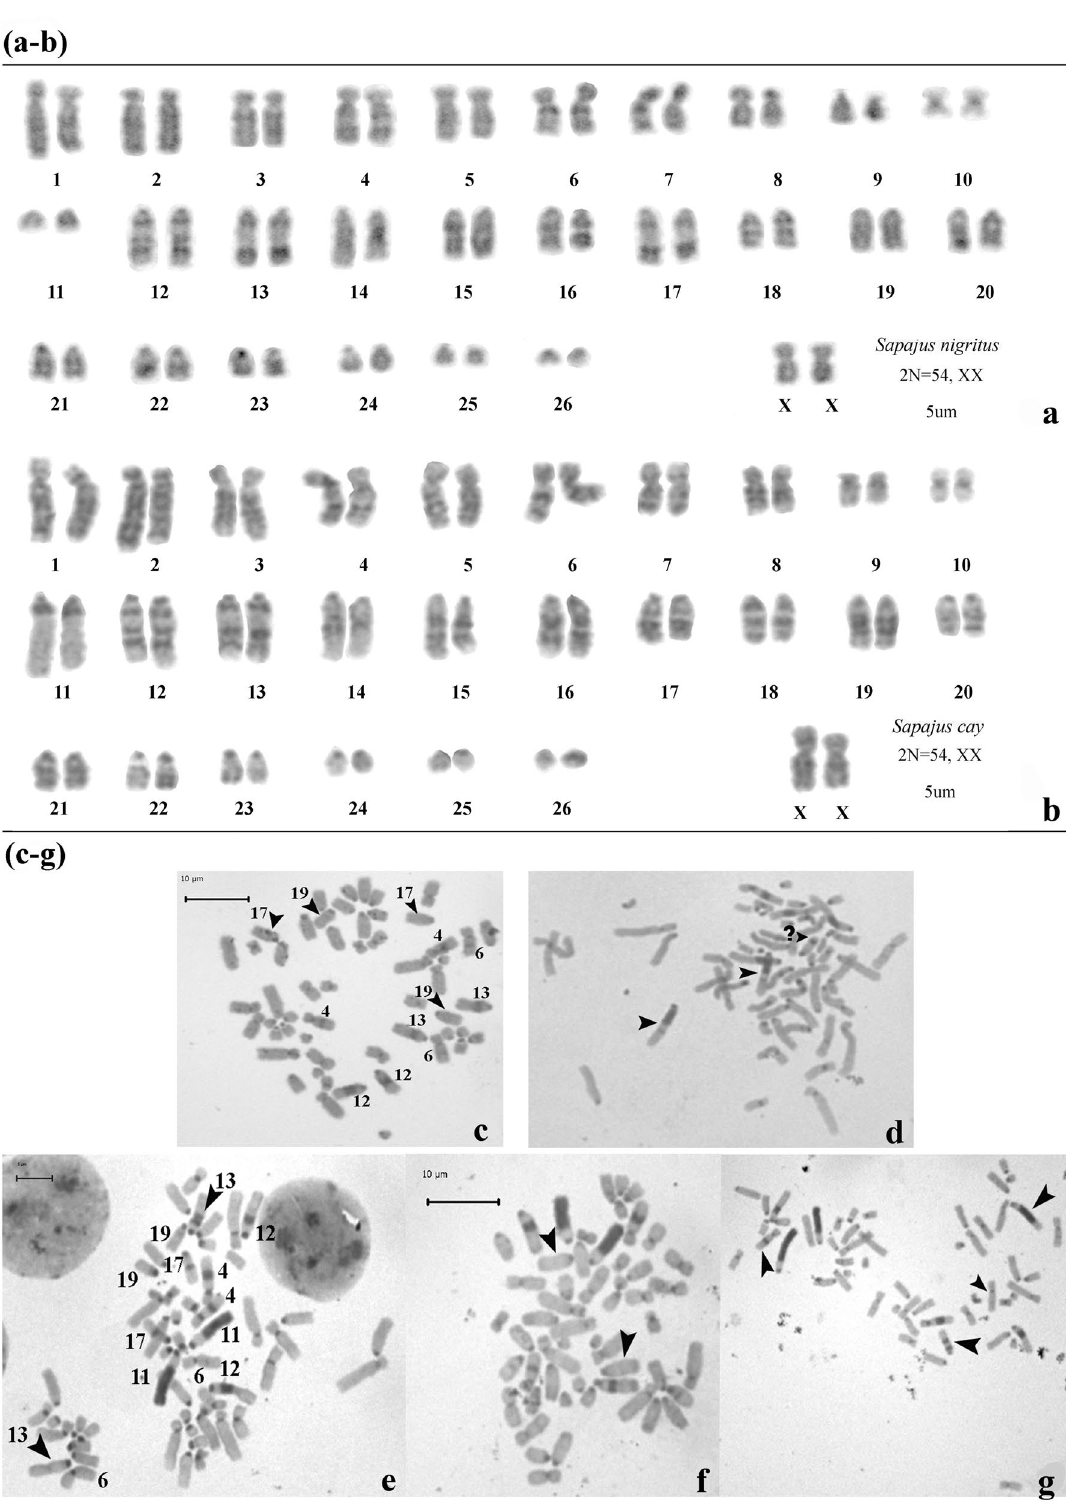
Figure 3. G and C banding patterns and polymorphisms found among the studied individuals. ( a , b ) G-banded patterns observed in SNI and SCY respectively. ( c – g ) C-banded metaphases illustrating different heterochromatin polymorphisms found in both species, highlighted with arrows. ( c ) Polymorphisms in chromosomal pairs #13, 17 and 19 of Sapajus nigritus and a paracentric inversion resulting in a new heterochromatic band. ( d ) (?) shows an undescribed band. ( e – g ) Polymorphism in chromosomal pair #13 of Sapajus